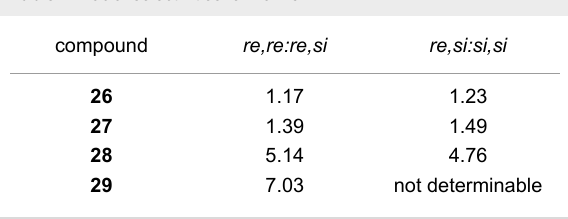
Table 2: Facial selectivities for 26 – 29